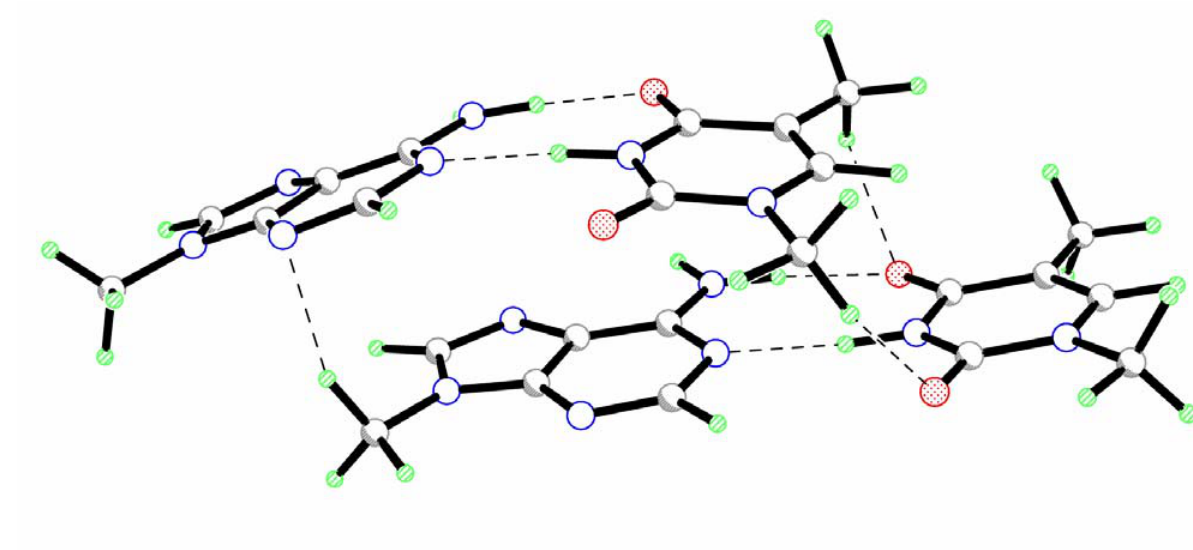
Figure1. Geometry of the head-to-head isomer of a stacked dimer of the AT pairs (AT-AT). rather small (Table 1). This indicates that two base pairs keep an almost parallel orientation of their mean planes. However, their long axes (y axes) form an angle of about 15 o . This value is considerably smaller than the standard helix twist angle (32-45 o [1]). Nevertheless, one can assume that the rotation of two base pairs with respect to each other is an intrinsic property of stacked base pairs. Two base pairs are significantly displaced with respect to each other toward the y axis (Table